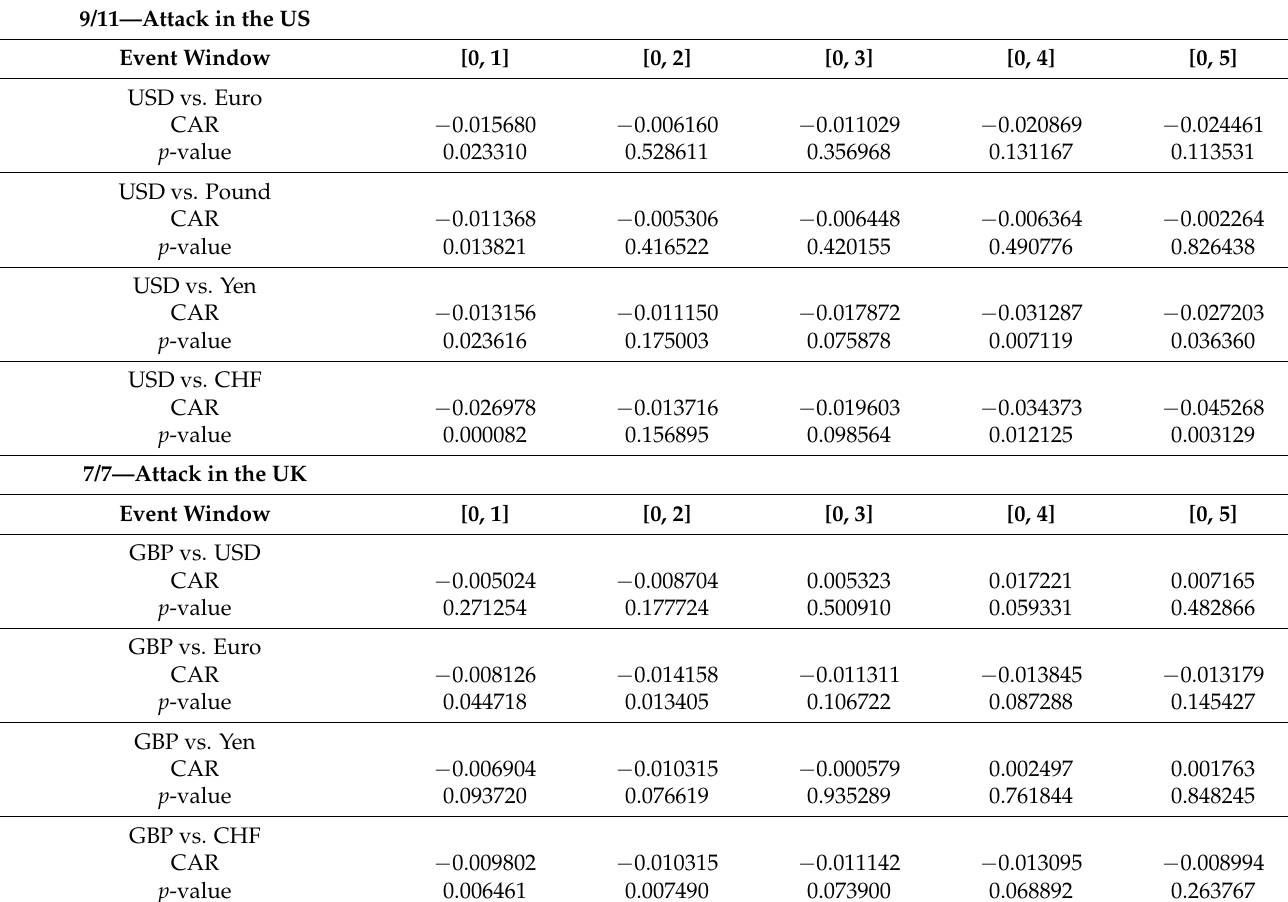
Table 4. Analysis of the effect of the 11 September 2001 attack in the USA (on the USD) and the 7 July 2005 attack in the UK (on the